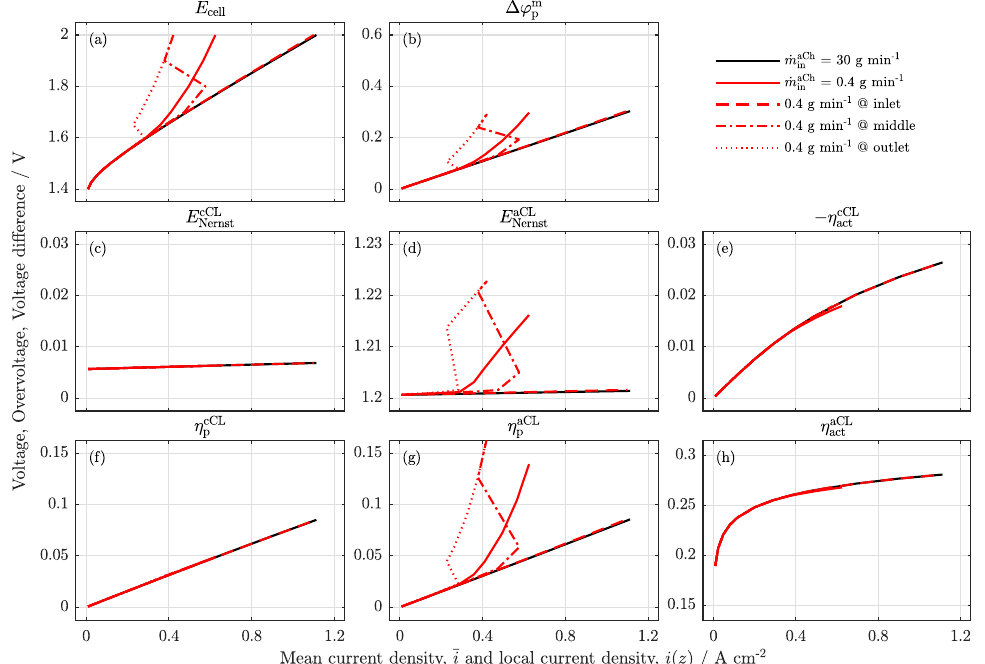
Figure 7. Cell voltage loss breakdown for reference scenario at 30gmin − 1 (black full line) and a low stoichiometry operation at 0.4gmin − 1 for full cell (full red lines) and locally: at the inlet (dashed red lines), the middle region of the cell (dash-dotted red line) and the outlet region of the cell (dotted red lines). ( a ) Cell voltage, ( b ) ohmic membrane voltage difference, ( c ) Nernst potential at the cathode, ( d ) Nernst potential at the anode, ( e ) cathode activation overpotential, ( f ) cathode proton potential, ( g ) anode proton potential and ( h ) anode activation